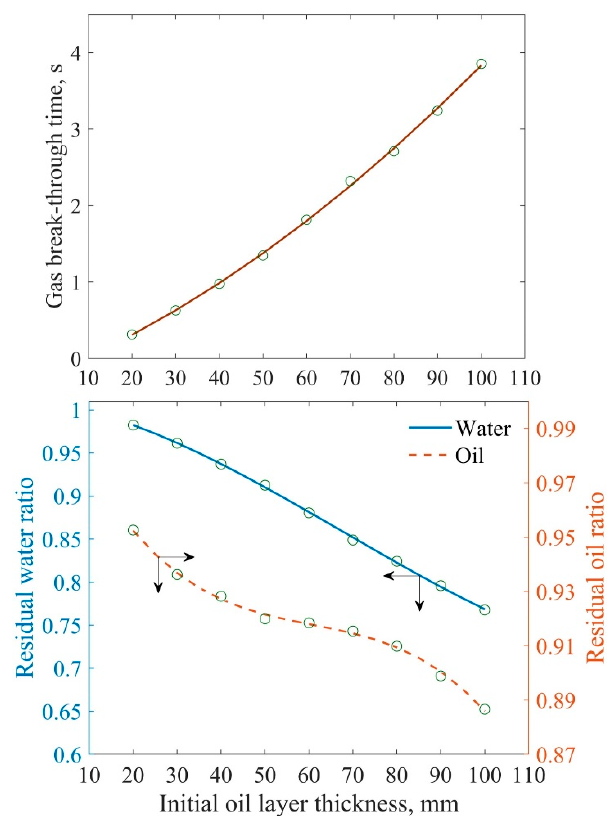
Figure 5. Upper panel: Effect of initial oil layer thickness on gas breakthrough time. Lower panel: Effect of initial oil layer thickness on residual ratios of both liquids. Initial l–l interface 10 mm above the outlet, with a pressure difference of 0.3 bar and oil viscosity of 0.131 Pa·s (cf. Table 2).